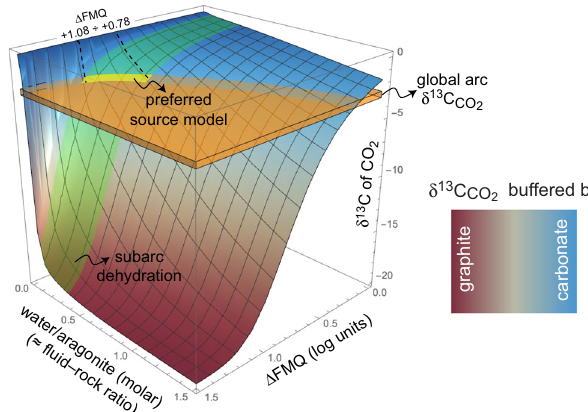
Fig. 4 Mathematical model showing the predicted δ 13 C of CO 2 as a function of both Δ FMQ and water – aragonite ( ≈ fl uid – rock) molar ratio. Modelled CO 2 is originated from oxidative dissolution of graphite and interacts with aragonite and aqueous fl uids at 3 GPa and 700 °C. Brown surface color: δ 13 C buffered by graphite. Blue surface color: δ 13 C buffered by aragonite. Orange box: global average δ 13 C of arc CO 2 4 ; the intersection with the mathematical model shows that arc CO 2 signatures are met for a wide range of Δ FMQ and fl uid – rock ratios. Preferred model (yellow fi eld) corresponds to the intersection among our mathematical model, the global average arc δ 13 C and typical fl uid – rock ratios at slab-top conditions assuming percolating fl ux (green fi eld; 0.05 – 0.33 molar = 0.01 – 0.06 mass). In this case, Δ FMQ ranging from + 0.78 to + 1.08 are derived for the source of carbon in the sedimentary slab at subarc